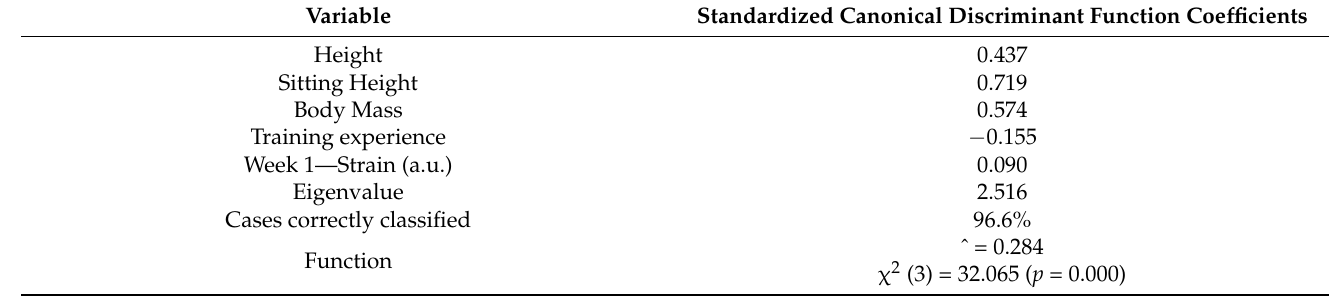
Table 2. Summary of standardized canonical discriminant function coefficients, eigenvalues, and correct classification cases for early and average maturing players in under-16 Portuguese National Team.